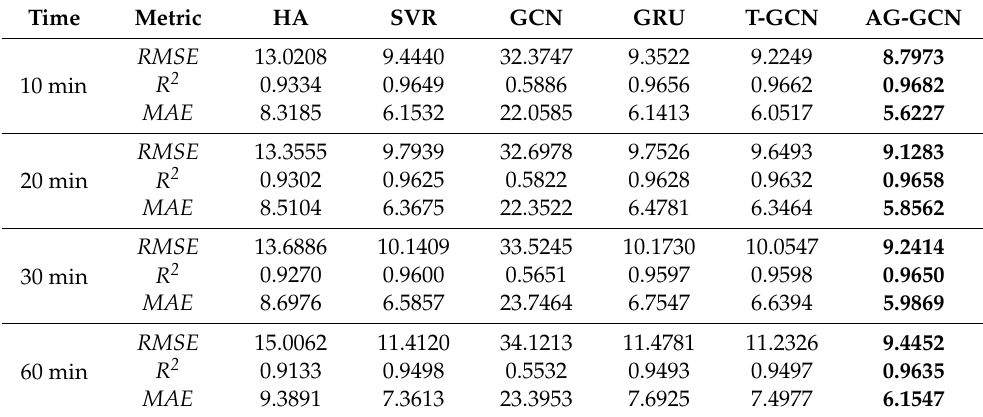
Table 2. Performance comparison of AG-GCN model and benchmark models for traffic flow predic- tion at different time